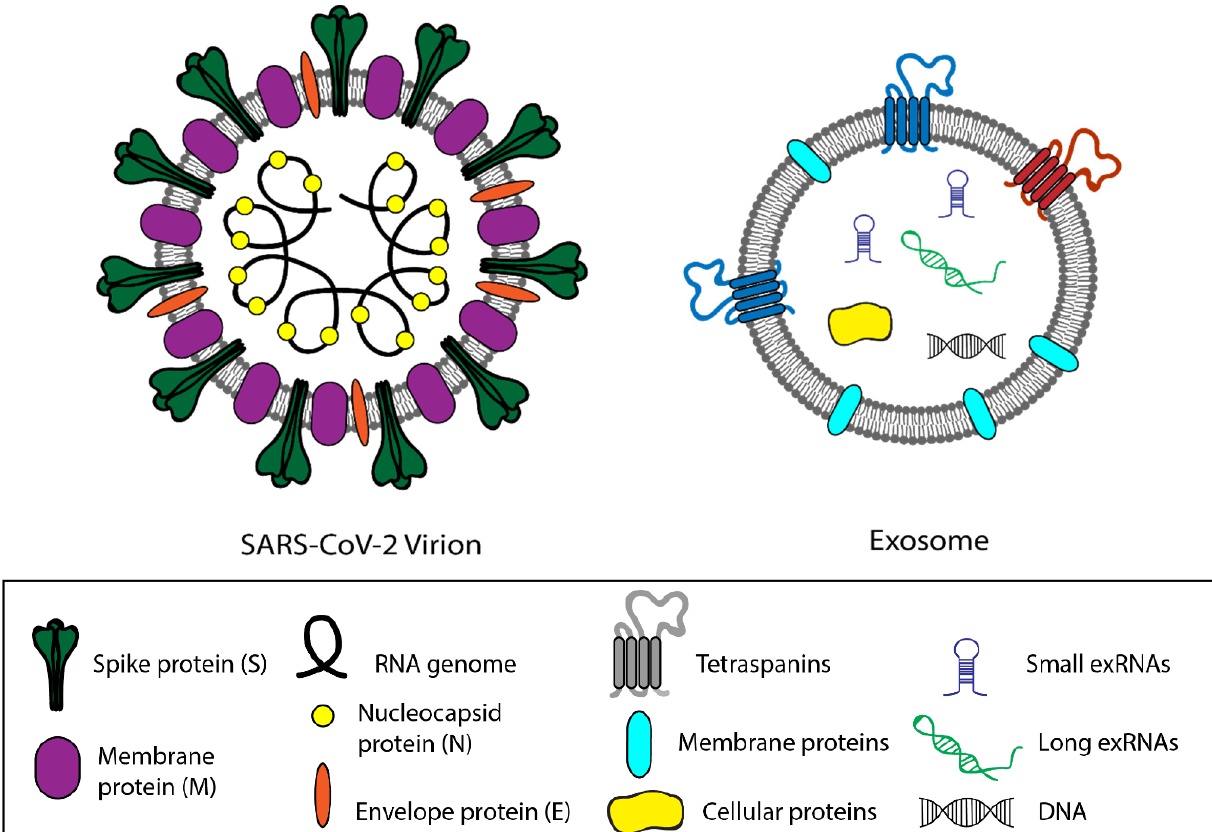
Figure 1. Similar biophysical properties of SARS-CoV-2 and exosomes.